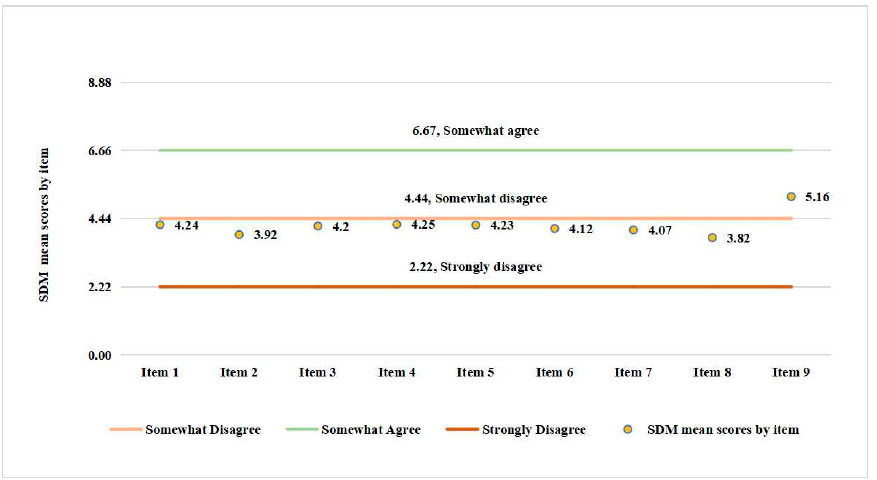
Figure 2. SDM-Q-9 mean scores by item.